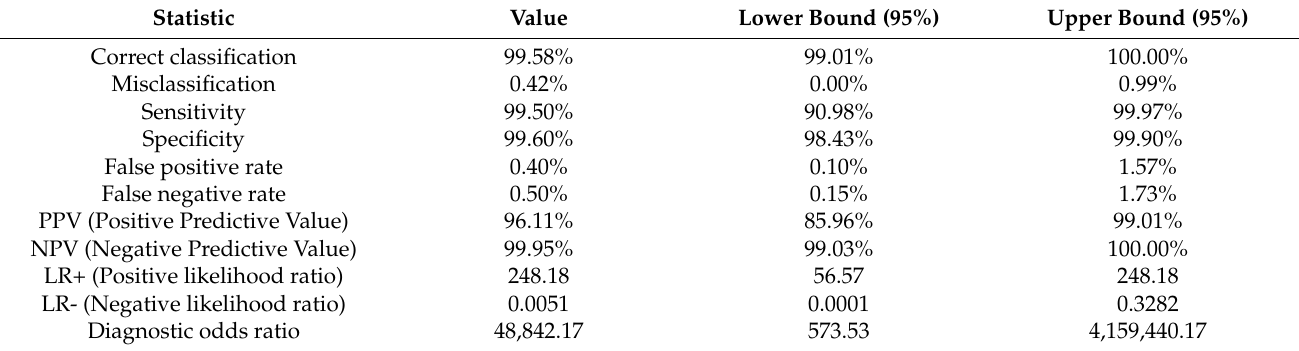
Table 3. Properties of c-ELISA test.